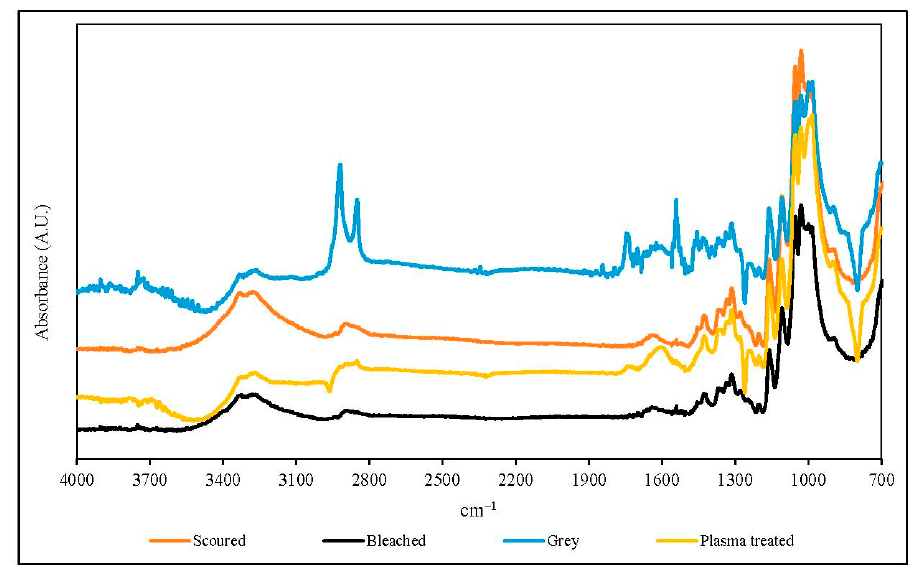
Figure 11. Fourier-transform infrared spectroscopy-attenuated total reflection (FTIR-ATR) spectra of single jersey fabrics (plasma condition: 150 W output power and 0.4 L/min oxygen flow rate).